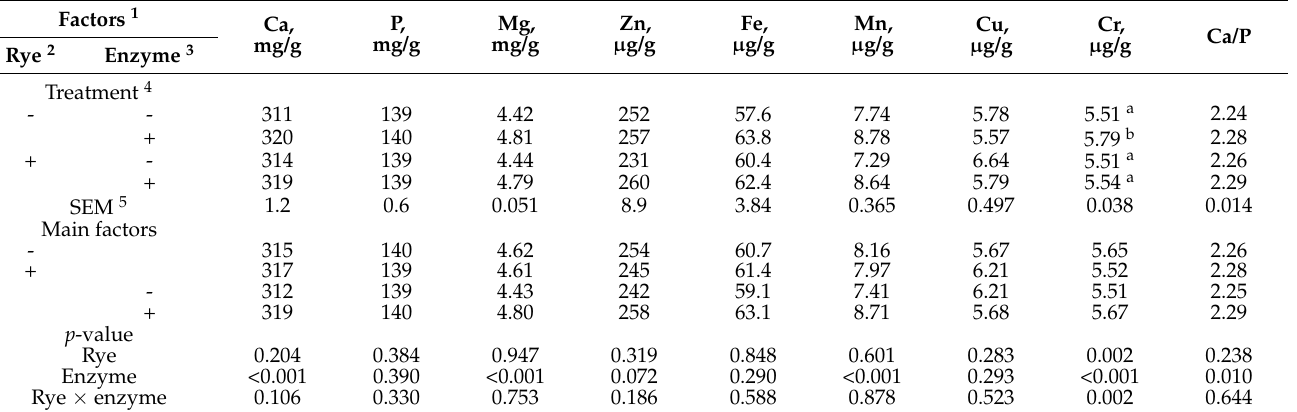
Table 7. Effect of dietary 25% rye inclusion and xylanase supplementation (200 mg/kg of feed) on hens’ tibial mineralization at the end of the laying